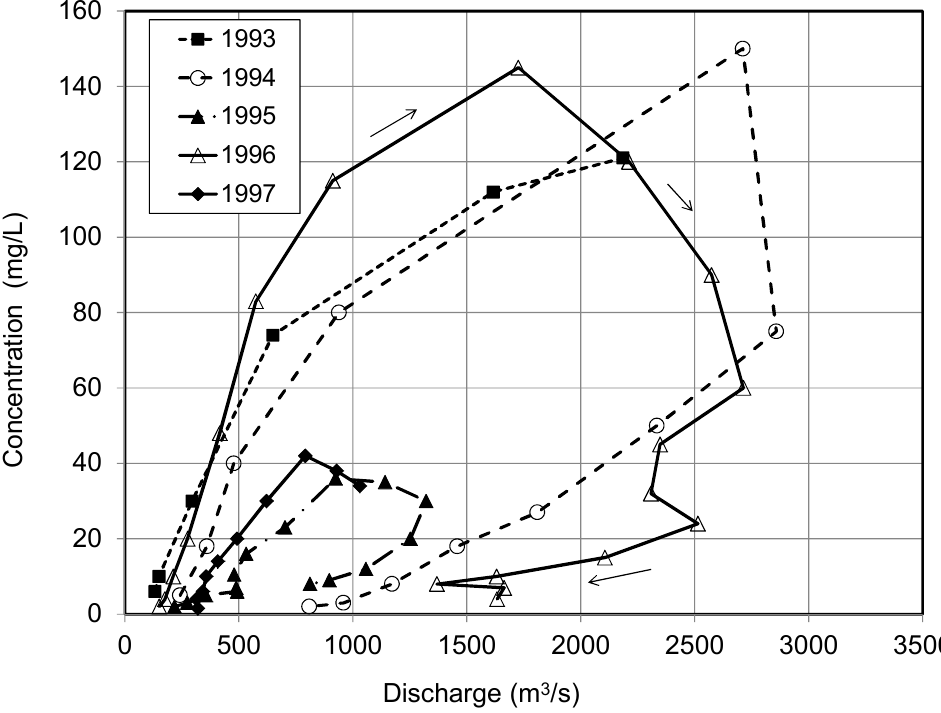
Figure 7. Daily mean values of runoff-generated SSC versus daily mean discharge during the spring freshet. Saint John River at Clair, 1993 to 1997. Time increases in the direction indicated by the arrows. From [34], Crown copyright, published by Elsevier.